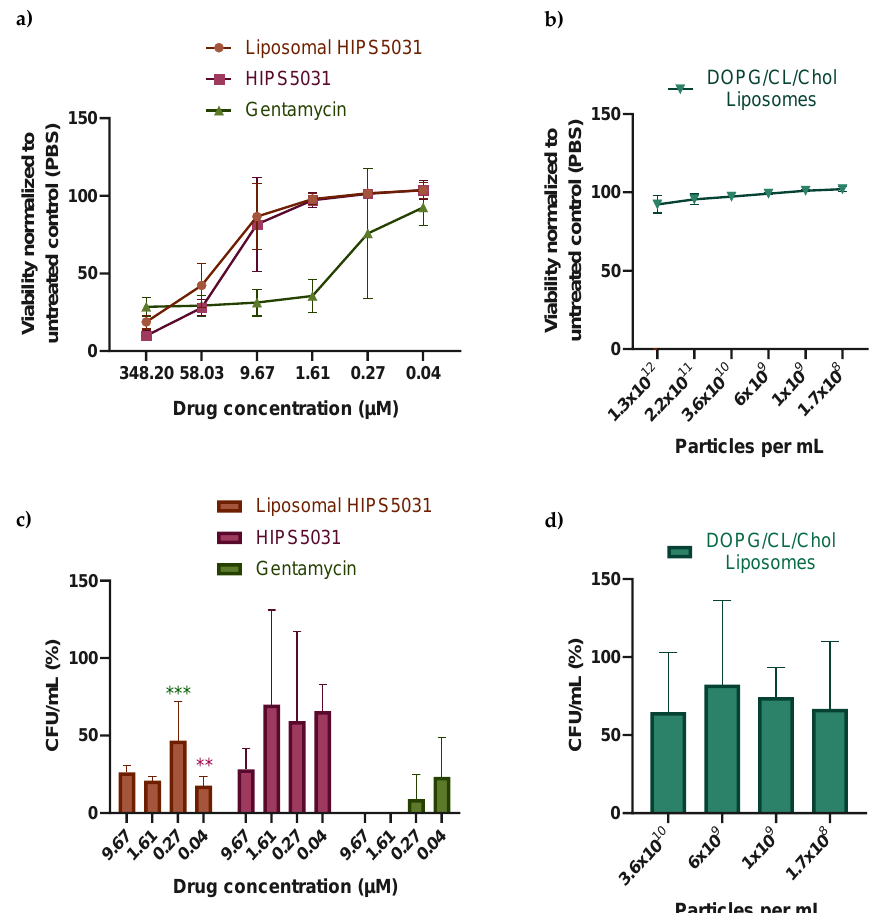
Figure 6. Bacterial viability assay based on the fluorescent signal derived from the reduction of resazurin to resorufin by metabolically active cells (alamarBlue HS, Invitrogen). Liquid cultures of B. subtilis 168 were incubated with serial dilutions of gentamicin, HIPS5031 , and liposomal HIPS5031 ( a ) as well as with pure liposomes ( b ). The fluorescence intensity as measured with a microplate reader (560/590 nm) was normalized to the untreated control (PBS). n = 9 for three biological replicates. After fluorescence measurements, colony-forming units were determined ( c , d ) and normalized to the untreated control (PBS). While HIPS5031 and liposomal HIPS5031 affected cell viability similarly and limited the regrowth of CFUs, unloaded liposomes (DOPG/CL/Chol) did not significantly impair B. subtilis ’ viability and growth of colonies. Liposomal HIPS5031 was less effective compared to gentamicin, but reduced CFU/mL to a larger extent than the free drug at 0.04 µM with p = 0.01 (multiple t-tests followed by Holm–Sidak post hoc test). n = 3 (biological replicates). Magenta stars = comparison to free HIPS5031 , green stars = comparison to gentamicin. ** p = 0.01, *** p = 0.001. B. subtilis cultures were incubated with solutions containing equimolar amounts of HIPS5031 , liposomal HIPS5031 , and gentamicin (all 348.2 µ M) or with pure